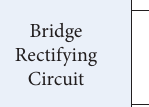
Figure 2: Diagram of the bridge rectifer circuit.